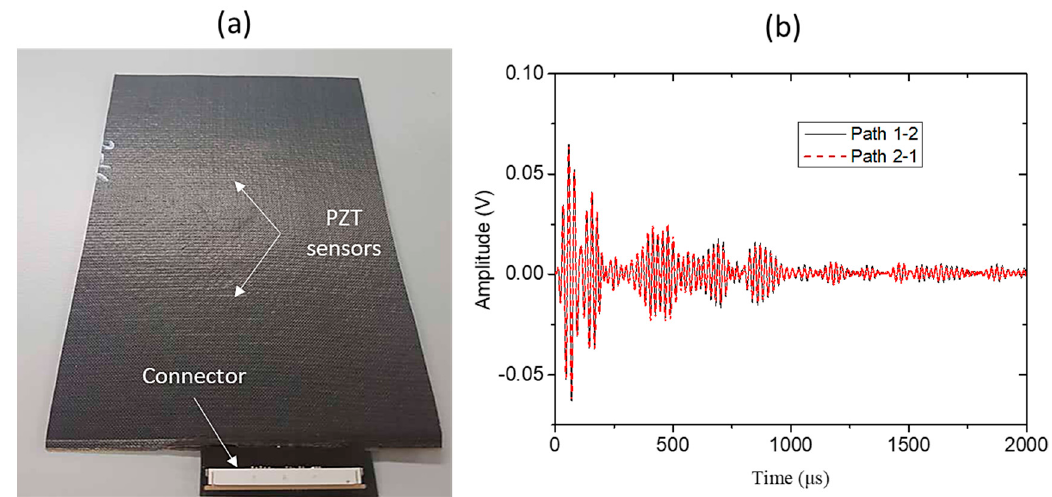
Figure 15. ( a ) Diagnostic thin film embedded within a CFPP plate and ( b ) the recorded signals from the PZT sensors.